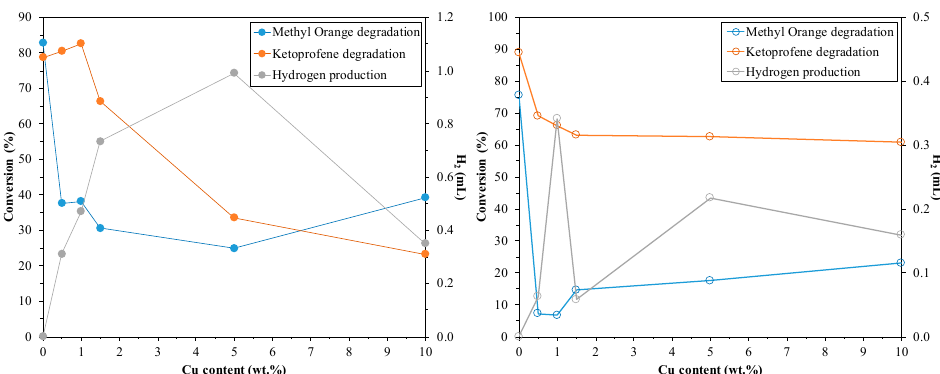
Figure 11. Correlation between the copper content and the achieved photocatalytic performance (degradation efficiency at the end of the 120 min experiment—%) in the degradation of methyl orange, ketoprofen, and the total hydrogen production at the end of the 120 min experiment (mL) for both composite series (P25-based—left-hand image; AA-based—right-hand image image).